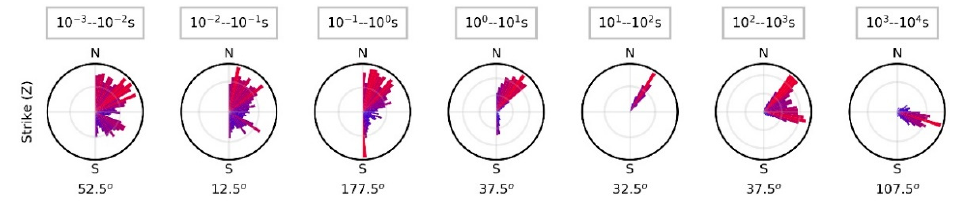
Figure 3. Geoelectric strike direction for different period bands: 10 − 5 –10 − 4 s; 10 − 4 –10 − 3 s; 10 − 3 –10 − 2 s; 10 − 2 –10 1 s; 10 0 –10 1 s; 10 1 –10 2 s; 10 2 –10 3 s; 10 3 –10 4 s; strike directions are shown as rose diagrams with a range of 0–180 degrees, where 0 is North and 90 is East. Rose diagram in each subfigure shows the statistical result of regional strike direction in the corresponding period band for all stations along the profile. Long bars on each site indicate the preferred principal axis which presents possible strike directions.